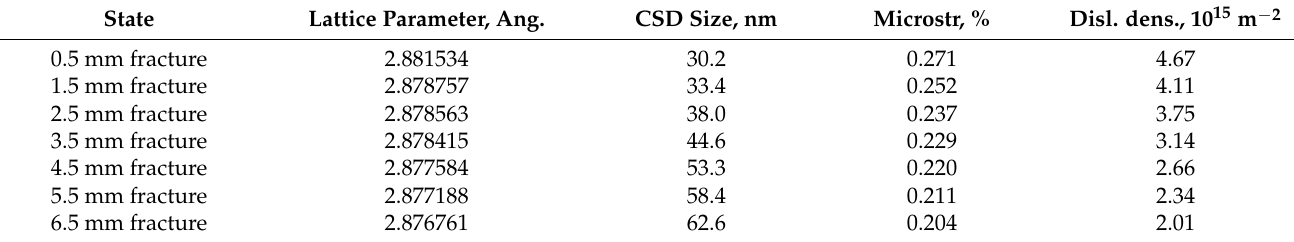
Table 4. XRD and TEM after the fatigue tests of the CR + requenching samples. State Lattice Parameter, Ang. CSD Size, nm Microstr,